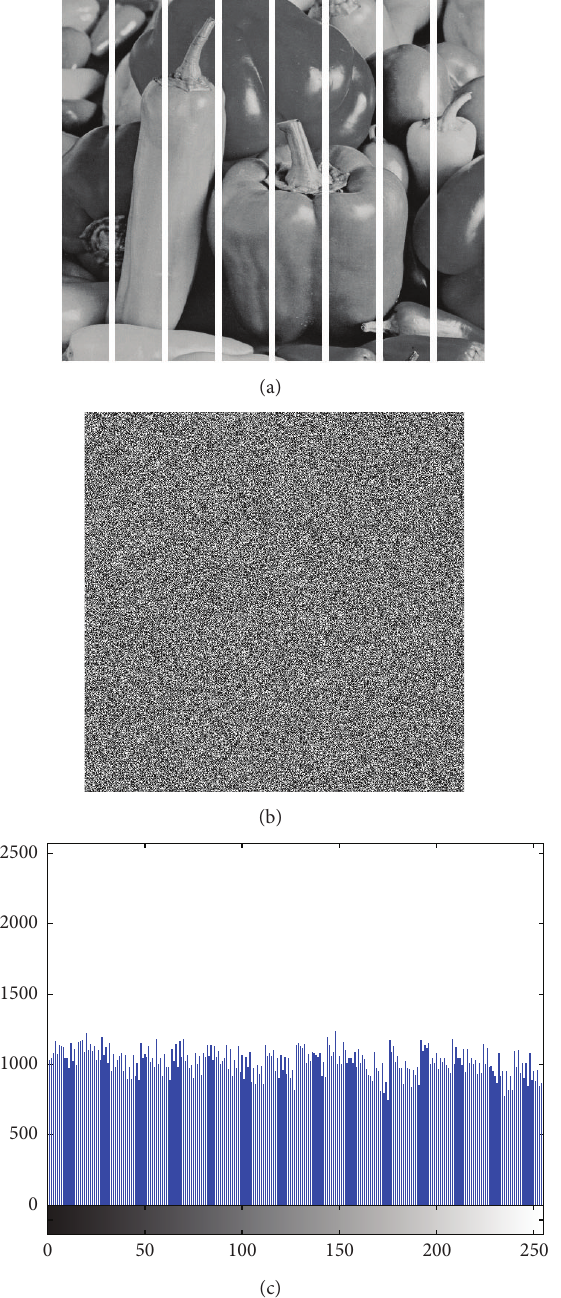
Figure 7: (a) Plain subimages, (b) plain image after four rounds of proposed bit permutation and (c) its histogram.